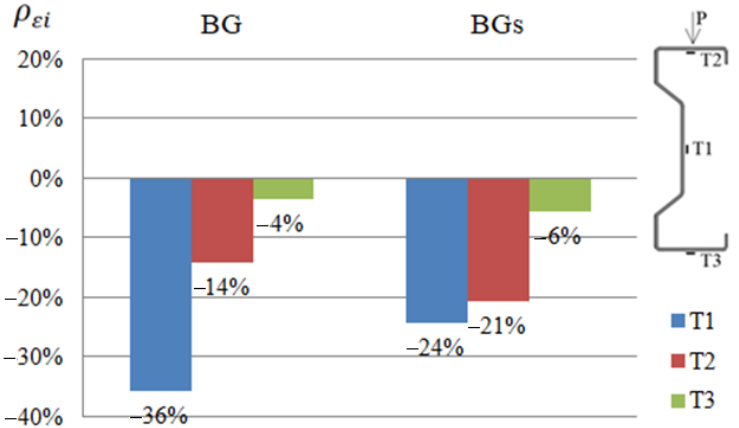
Figure 6. Percentage limits of strains ρ ε i at T1, T2, T3 points of the tested beams reinforced with steel or CFRP tapes on the upper flange, in relation to the reference beams at a load of 25 kN.